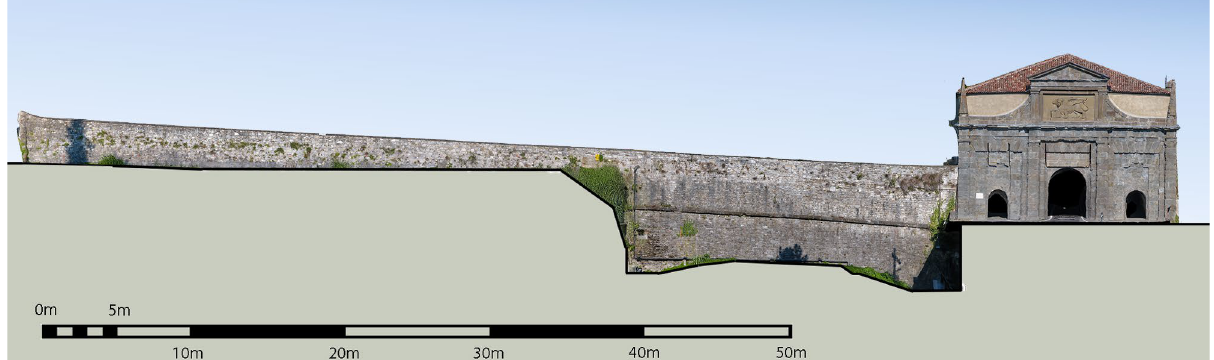
Figure 10. The orthographic projections of the Venetian Walls: the wall on the left of St. Augustine